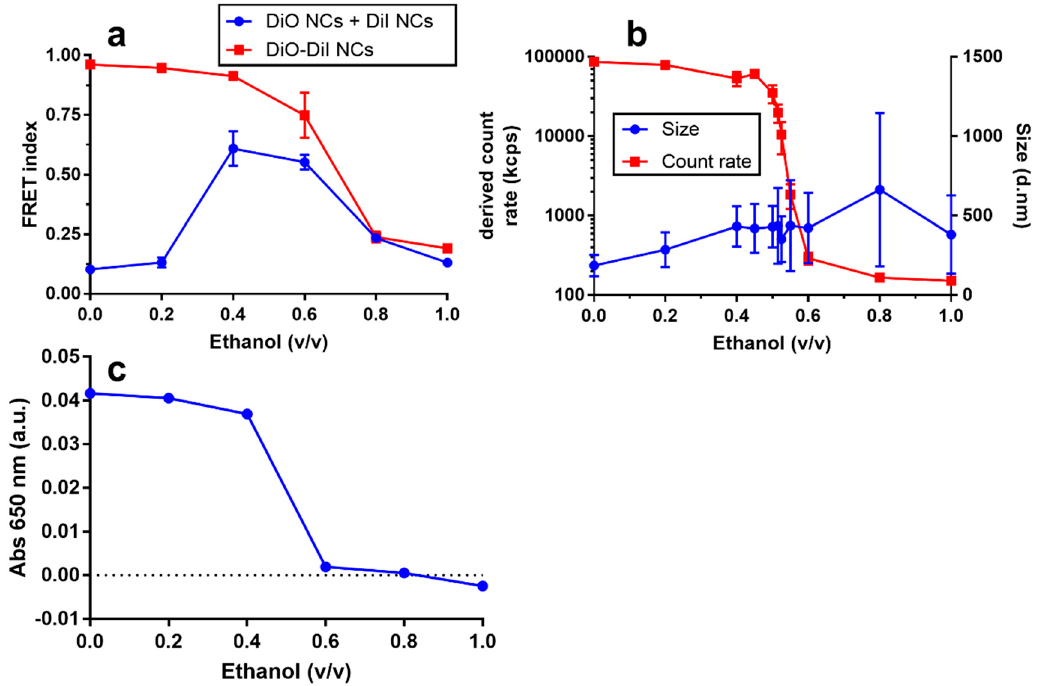
Figure 4. Effect of dissolution of fluorescently labelled nanocapsules (NCs) with increasing concentrations of ethanol, as characterized, by: ( a ) FRET index of a physical blend of DiO- and DiI-loaded (0.158 µ M) NCs and equimolar DiO/DiI-loaded NCs (0.158 µ M); ( b ) Derived count rate and Z-average size of equimolar DiO/DiI-loaded NCs (0.158 µ M) by DLS-NIBS; and ( c ) Absorbance ( λ = 650 nm) of equimolar DiO/DiI-loaded NCs. FRET index was calculated by measuring DiO (donor) emission in the presence and absence of DiI (acceptor) using Equation (1). Full spectra used to calculate FRET index are shown in Figure A1. Error bars represent standard deviation of triplicate measurements in all cases, except for size, where error bars represent mean PDI width in nm of triplicate measurements.